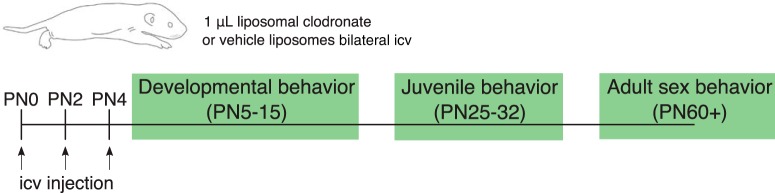
Treatment and behavioral testing timeline. Schematic depicting the ages at which treatments and behavioral testing were performed.